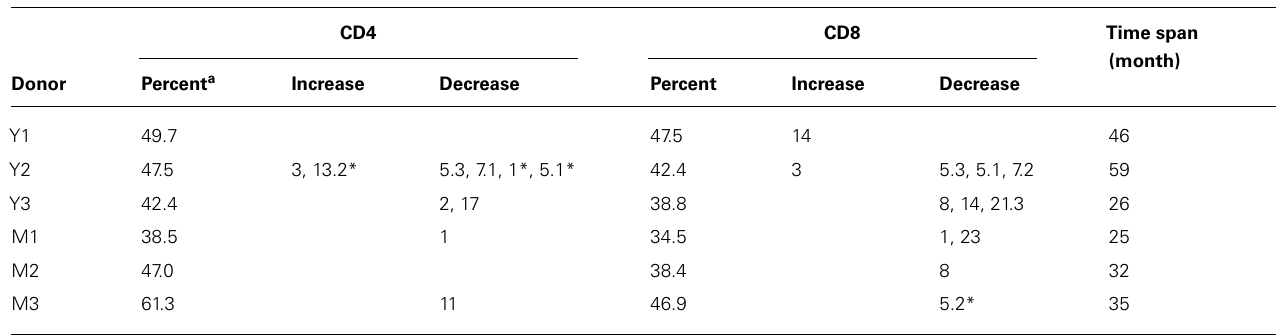
Table 2 |V β staining and change in CD4 and CD8T cells